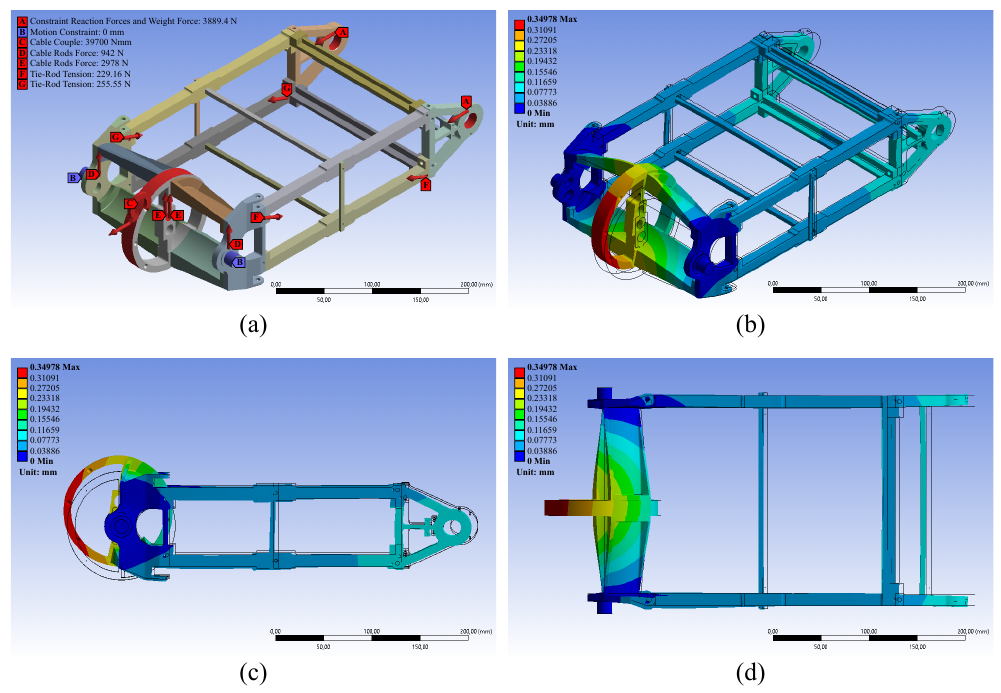
Figure 6. Results of the FEM analysis on the 1st module of the robotic arm. ( a ) shows the forces and constraint reaction forces acting on the module; ( b – d ) show the total resulting deformation in mm from different points of view, with a deformation scale factor equal to 71.